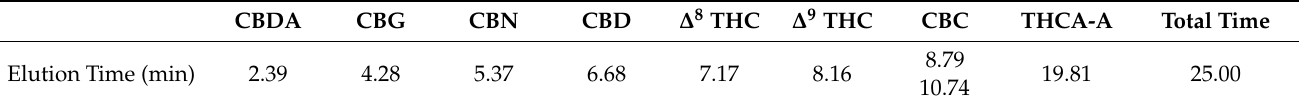
Table 5. Elution times for 10-cannabinoid reversed-phase separation on Chiralpak IG-U.